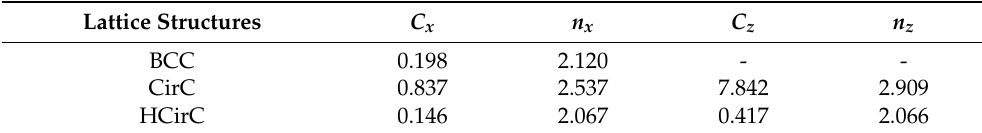
Table 3. Fitting results of the relationship in Equation